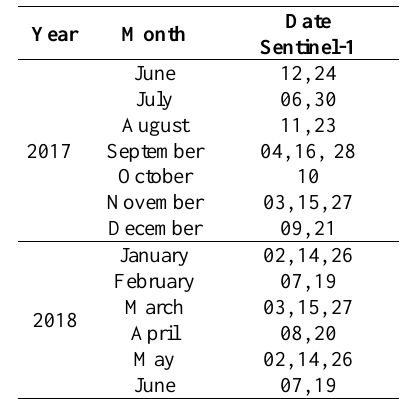
Table 1. Dates of Landsat-8/OLI and Sentinel-2/MSI image acquisitions over LEM.